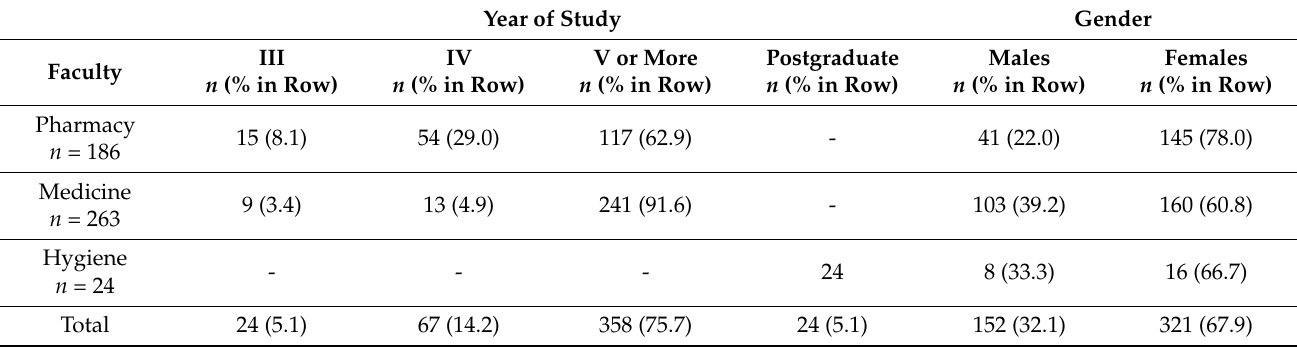
Table 1. Characteristics of the sample ( n = 473 students).